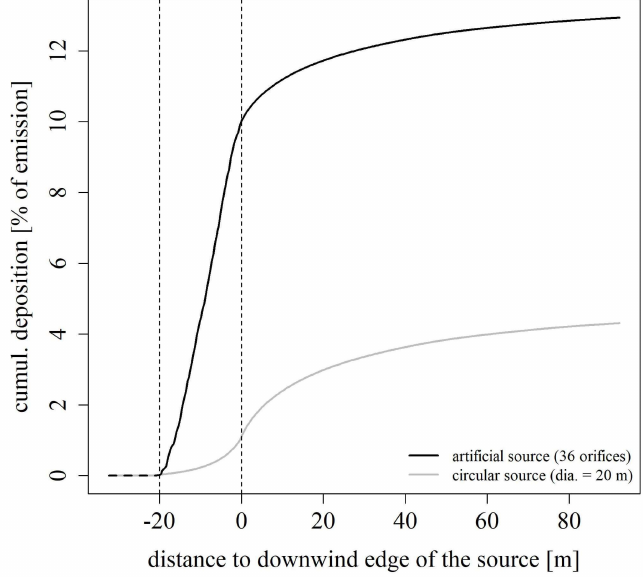
Figure 9. Modelled cumulative, cross-wind integrated fraction of emission (in %) that is deposited up to a distance downwind of the source, in the case of a multiple-orifice artificial source versus the case of a true circular area source (e.g., homogeneous slurry patch) of the same size. The atmospheric conditions were taken from measurement interval 6 (11h30 to 11h40). A model deposition velocity v ∗ of 0.35 cm s − 1 was